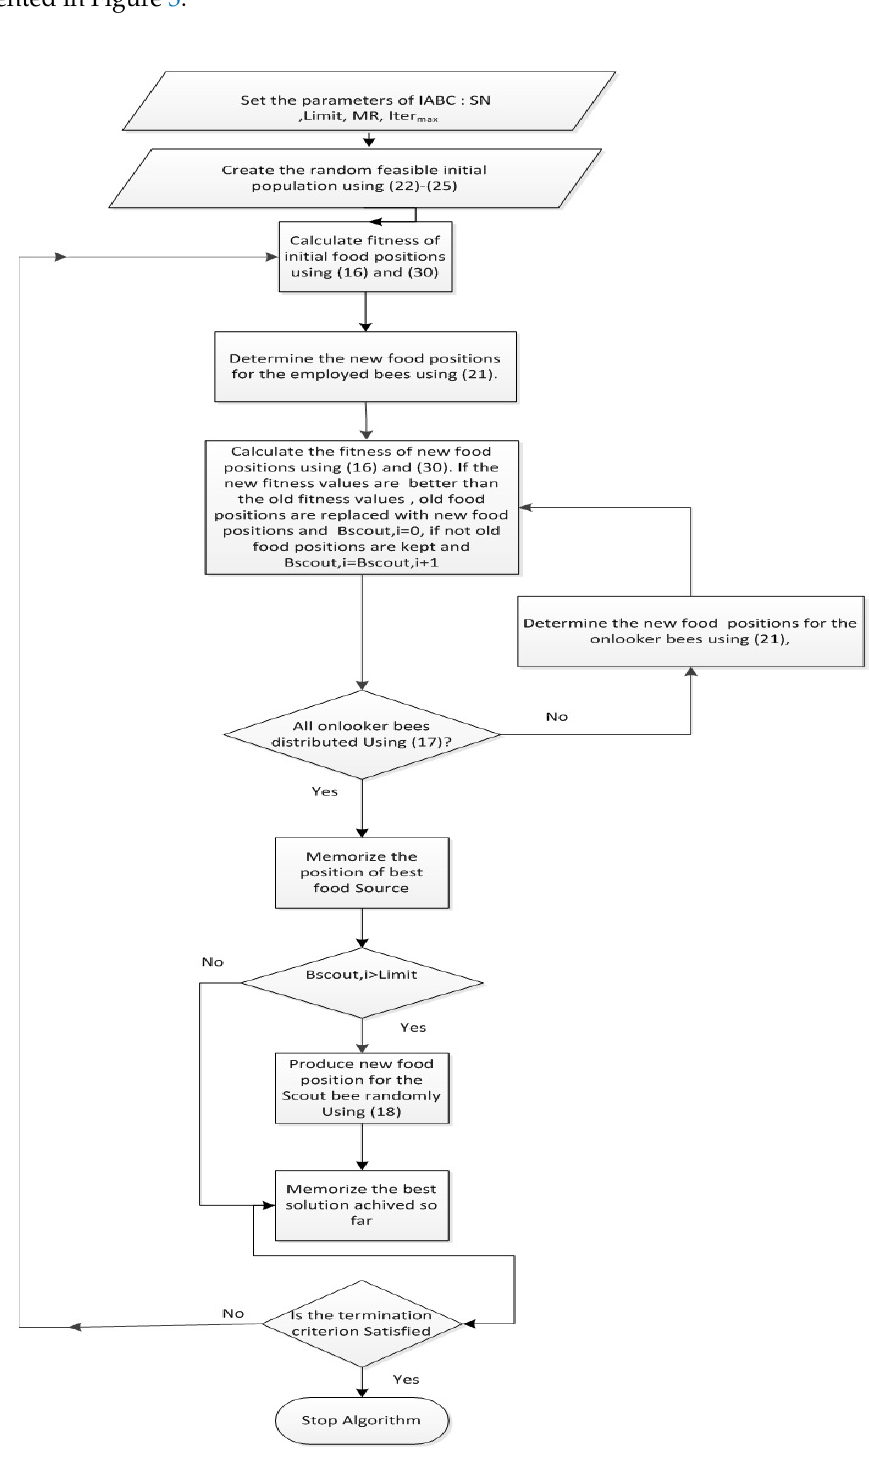
Figure 3. Flowchart of implementation process of proposed method on CHPED